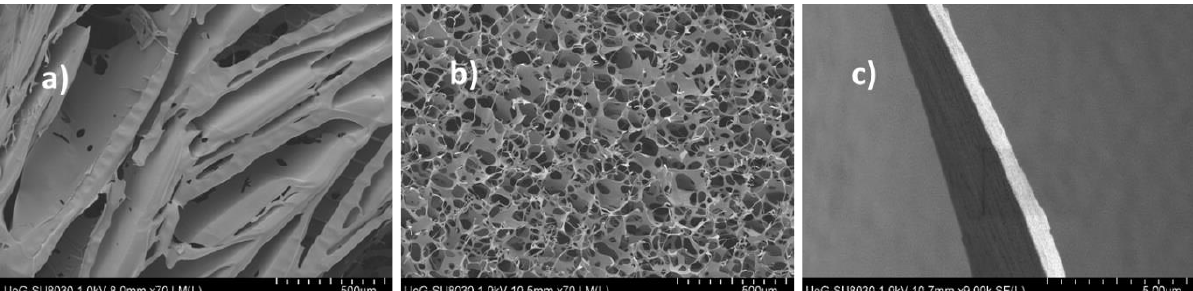
Figure 4. Shows topographical images of the composite SA*:FCOL:HA loaded with 75 µg/g BSA ( a ) top of the scaffold with an average pore size of 275 µm; ( b ) bottom of the scaffold with an average pore size of 122 µm and ( c ) wall thickness ranging from 0.234 – 0.999 µm.